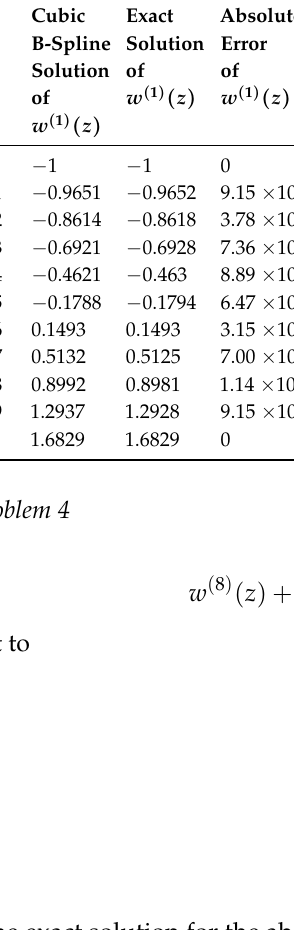
Table 10. Absolute errors at all derivatives at h = 1